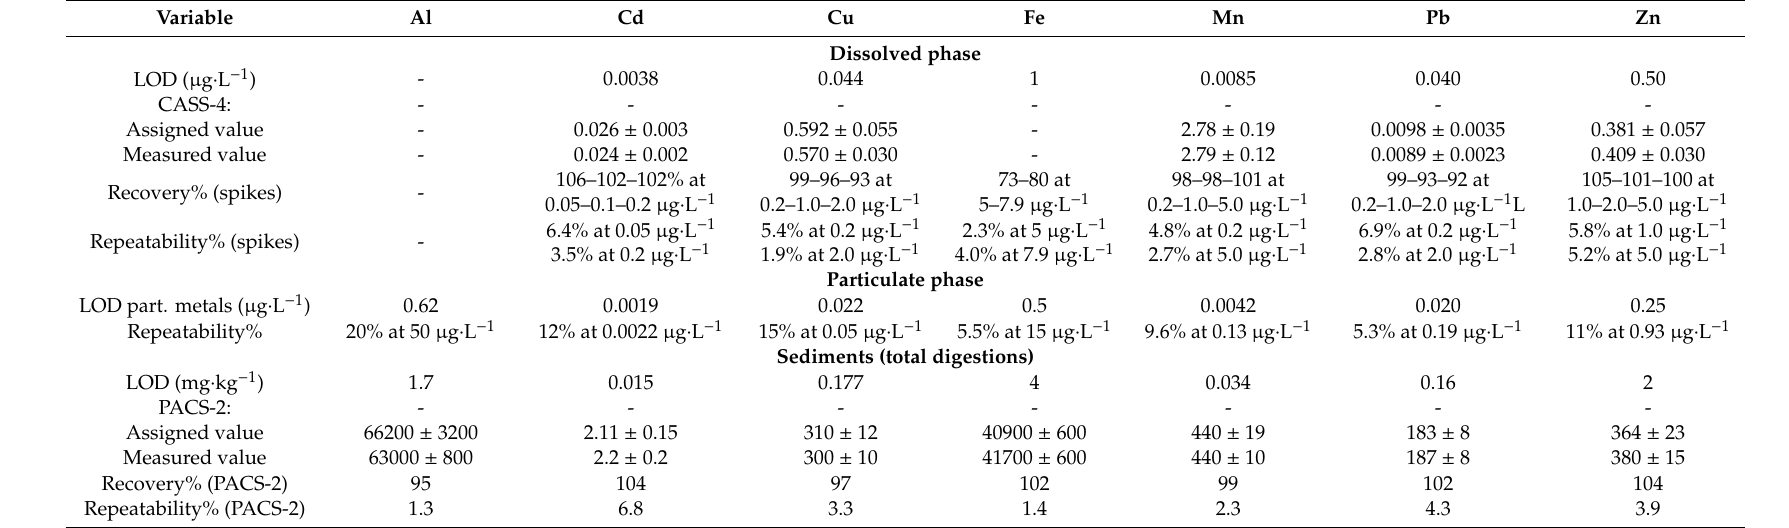
Table 1. Quality assurance data of the methods employed for the determination of metals in the dissolved and particulate phase and total contents in sediments.